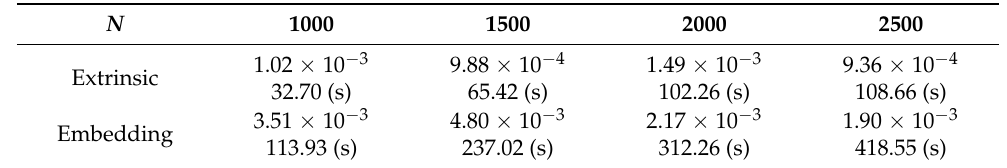
Table 3. Example 1: L 2 error and CPU time by using extrinsic and embedding approaches with different numbers of training data under width = 50 and depth =